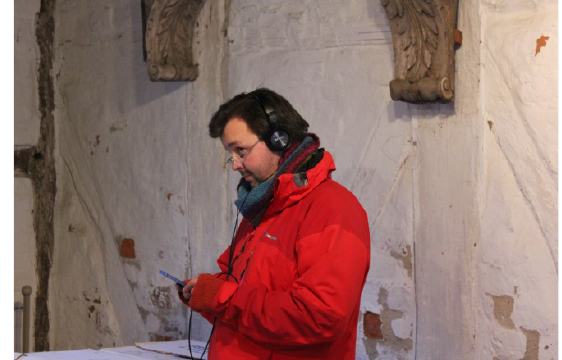
Figur e 12. Headphones concentrate the attention to the mobile app. Sydvestjyske Museer,